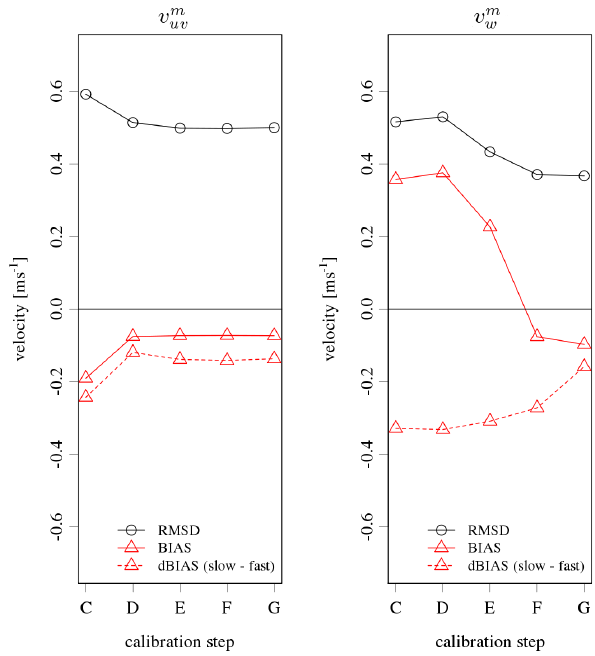
Fig. 13. Influence of the calibration steps C–G on root mean square error (RMSE) and bias (BIAS) between weight-shift microlight aircraft and all simultaneous ground based measurements of the horizontal ( v m uv ) and the vertical ( v m w ) wind components. dBIAS indicates the difference in BIAS between measurements at 27 and 24 m s − 1 true airspeed.